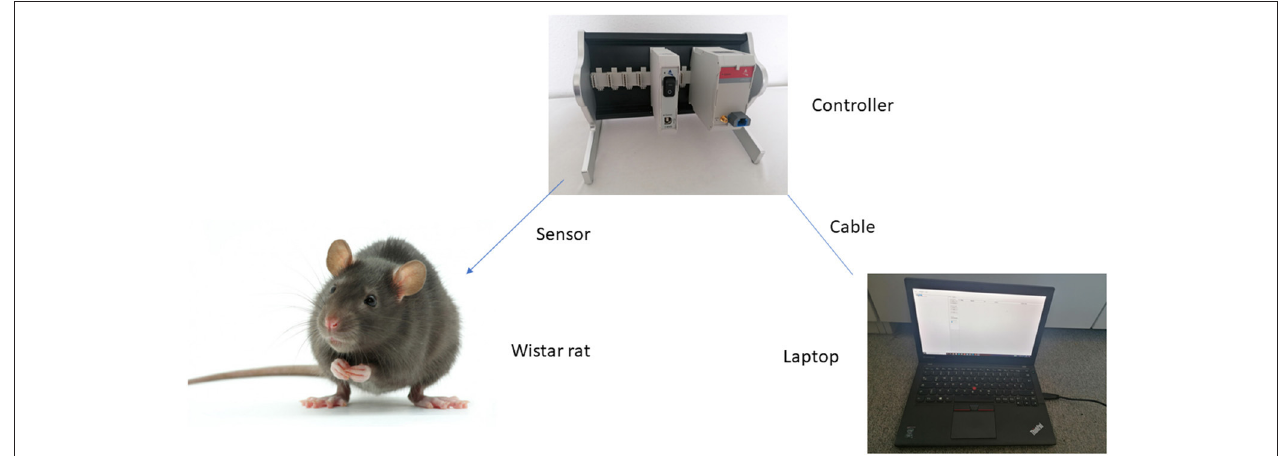
FIGURE 6 | Intraoperative situs. Arrow indicates sensor and cable, Ring indicates vessel. Insertion of the sensor.